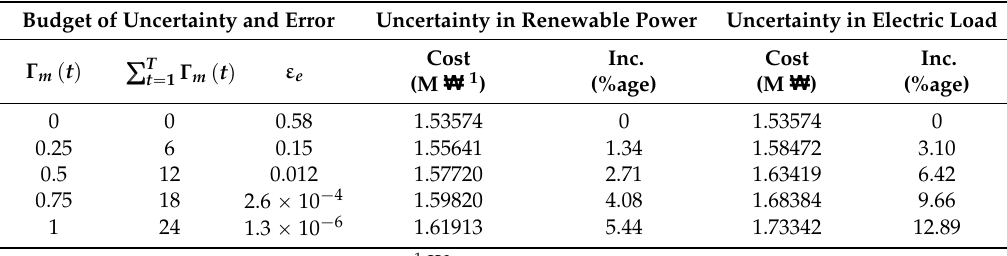
Table 2. Performance in grid ‐ connected mode with single source of uncertainty. Budget of Uncertainty and Error Uncertainty in Renewable Power Uncertainty in Electric Load